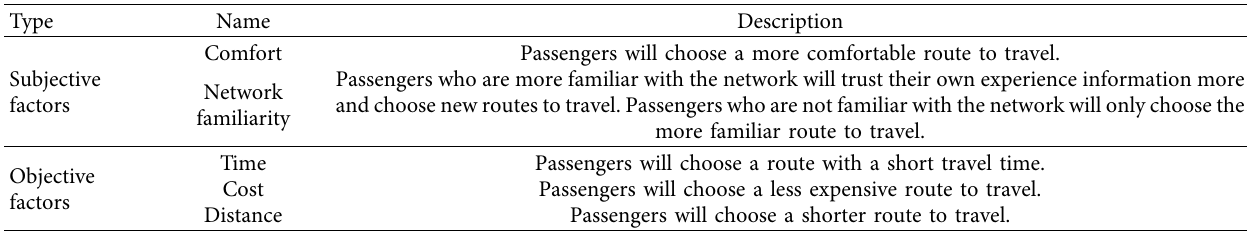
Table 2: Influencing factors affecting the passenger route